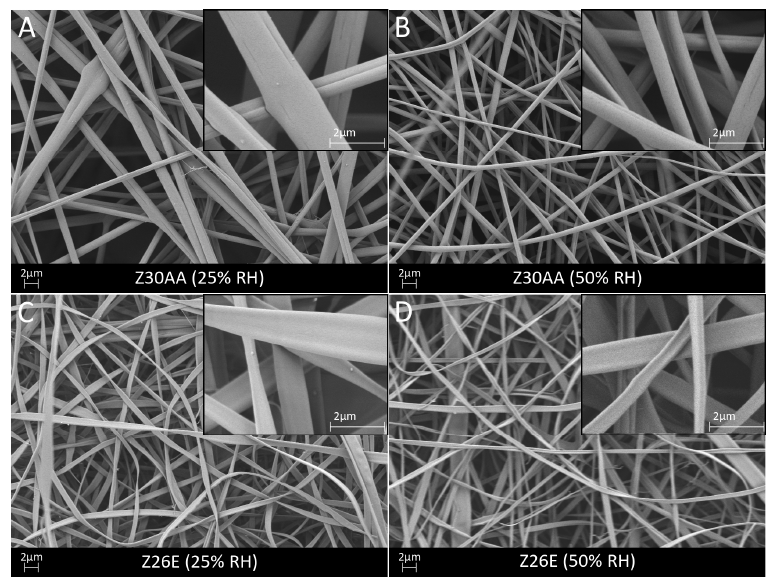
Figure 2. SEM micrographs of pure zein fibers using acetic acid (Z30AA) ( A , B ) and ethanol (Z26E) ( C , D ) as solvent at 25% and 50% relative humidity. The fibers are shown at 5000× magnification and at 20,000× magnification in the inserts.